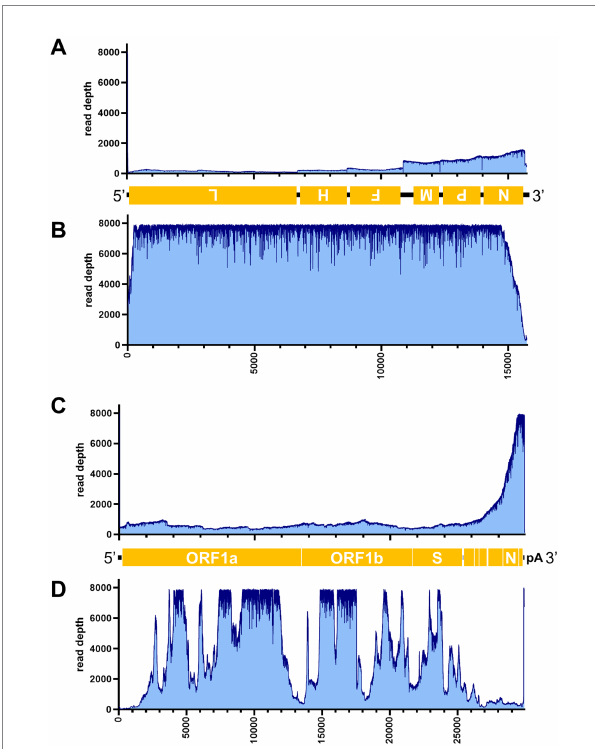
FIGURE 7 Read depth aligned to CDV and SARS-CoV-2 reference genomes. Read depth of CDV (A,B) and SARS-CoV-2 (C,D) across the genome using data generated from the PCR-NGS method [upper panels: (A,C) ] or RCA-NGS method [lower panels: (B,D) ] are shown. The schematic view of the open reading frames (ORFs) and UTRs are shown as yellow boxes and black lines in the 5 ′ -to-3 ′ direction. The product of ORF is shown in the box, and the turned letter indicates the ORF is in the reverse complement (i.e., 3 ′ -to-5 ′ direction). The number of reads (y-axis) obtained at each nucleotide base pair position (x-axis) is